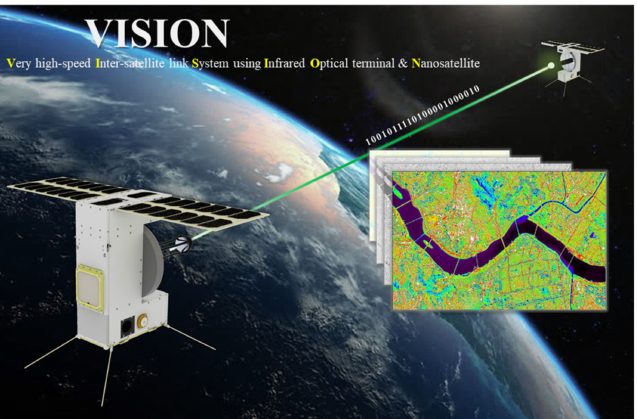
Figure 1. Conceptual illustration of the VISION mission. The proposed system can transfer large- sized image data and will be applied to construct a high-speed data relay system in